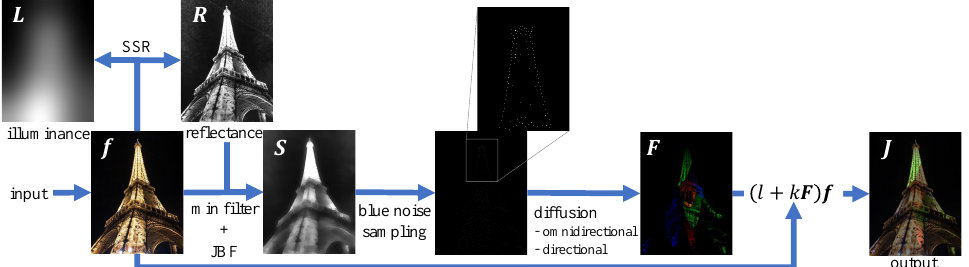
Figure 1. Overview of the proposed